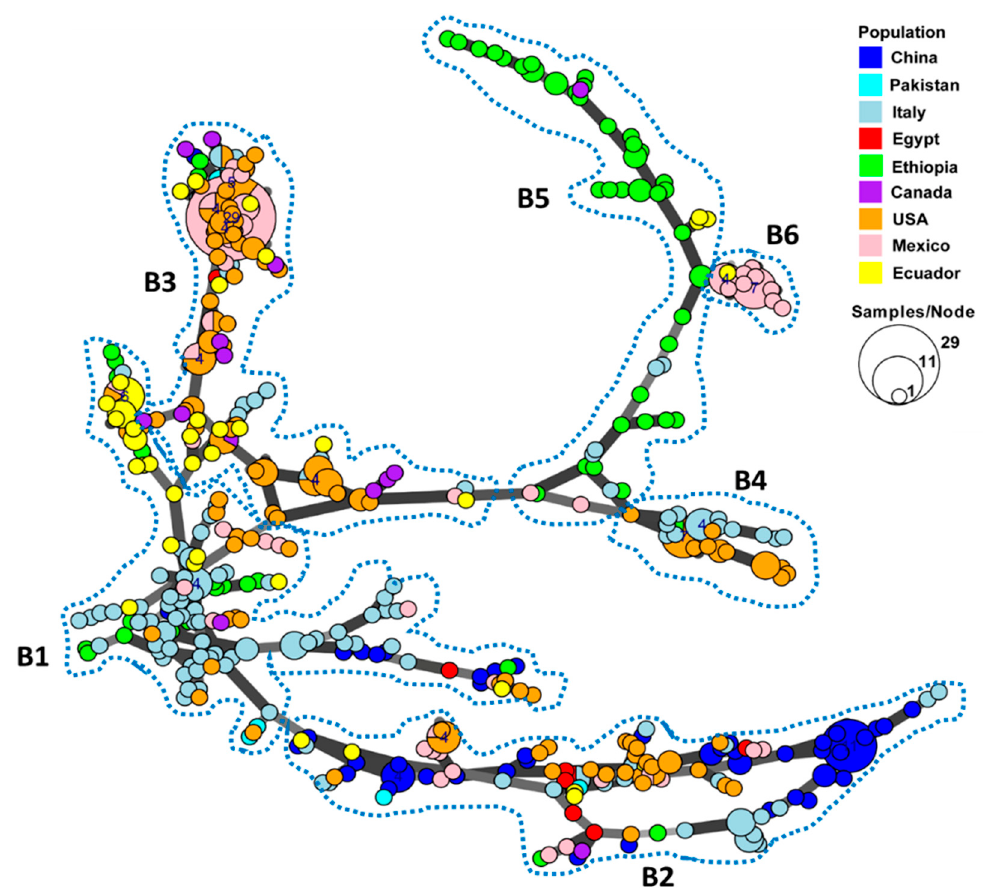
Figure 1. Minimum spanning network showing relationships among multi-locus genotypes (MLGs) of Puccinia striiformis f. sp. tritici identified from nine countries. Each node represents a different MLG. The size of a node indicates the number of isolates in the MLG. Node colors represent countries from which the isolates were collected. Six major branches are marked by the broken close lines. B1–B6, branch 1–branch 6.